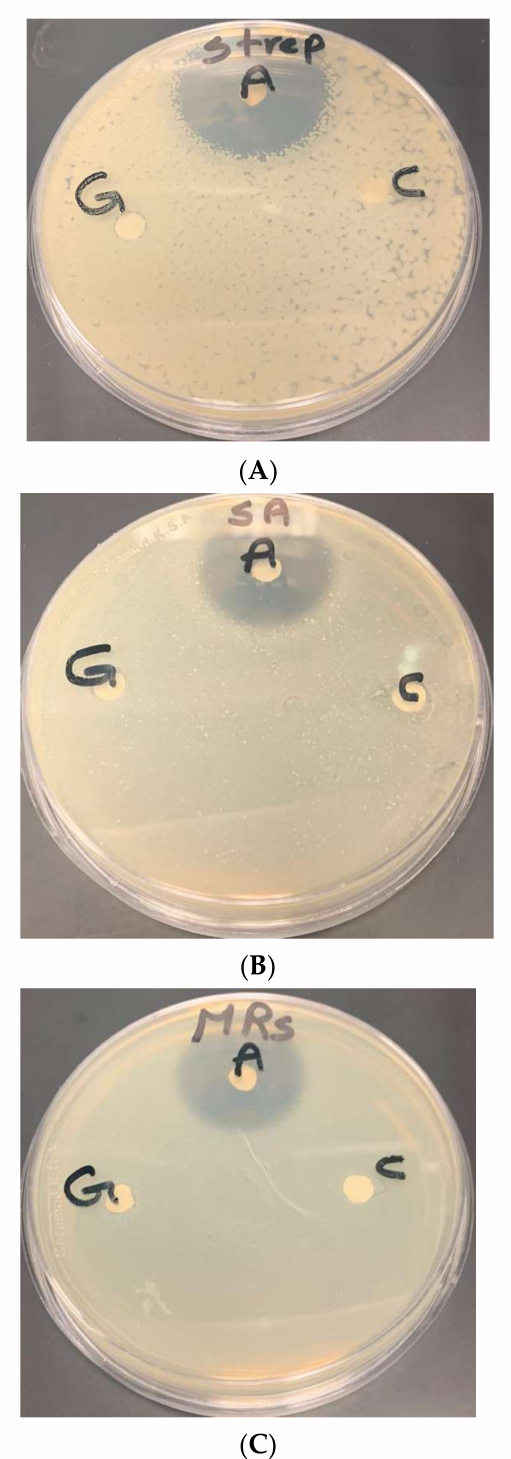
Figure 9. Inhibition zone of gold nanoparticles of Chlorella vulgaris extract against ( A ) Streptococcus sp., ( B ) Staphylococcus aureus , and ( C ) methicillin-resistant Staphylococcus aureus